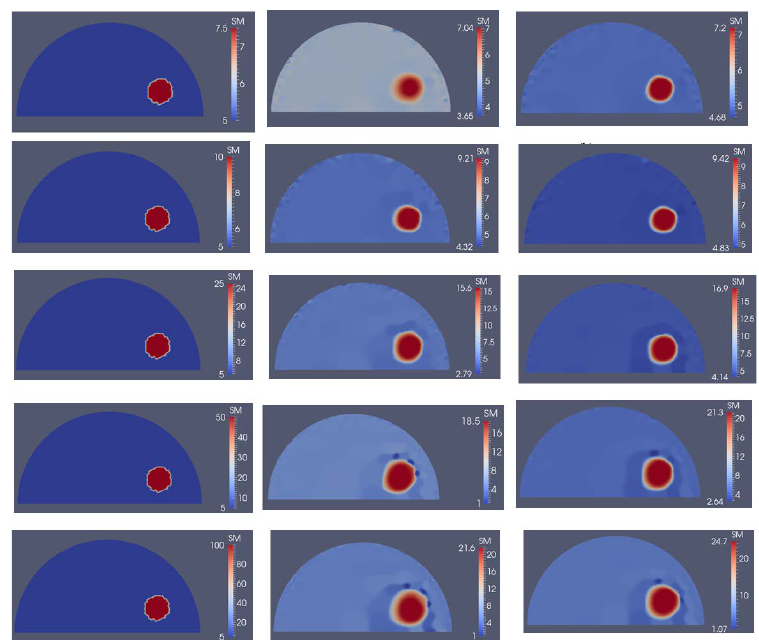
Figure 14. Problem domain with target shear modulus distribution is defined in the first column with varying shear modulus values in the inclusion from 7.5 (top row) to 100 kPa (bottom row) to test the feasibility range of stiffness detection. Columns 2 and 3 represent the shear modulus reconstructions with 5 and 10 boundary displacement data sets, respectively, using 0.1% noise.